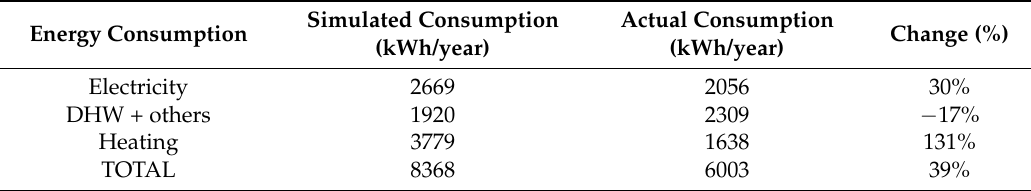
Table 7. Comparison of simulated and actual consumption in the average dwelling in building A, in kWh/year.